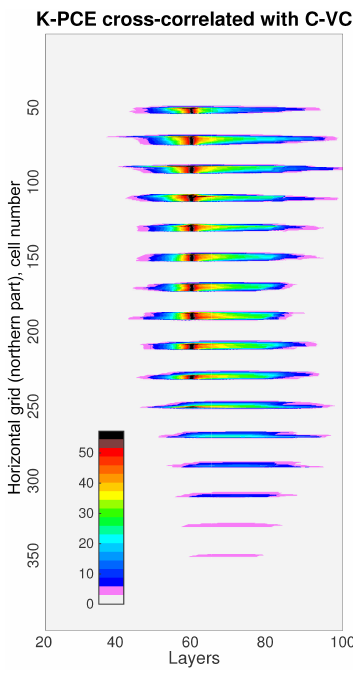
Figure 6. Individual cross-correlation terms of the background ma- trix P b associated with PCE biodegradation rate and VC concen- θx tration. The correlations are shown for all layers, assuming that the cells from each layer have been stretched in one vertical line ( y axis). The largest correlation is present in layer 60 where the con- taminant source is located. Biodegradation in shallow layers is not as strong as in deep layers because of the downwards groundwater- flow